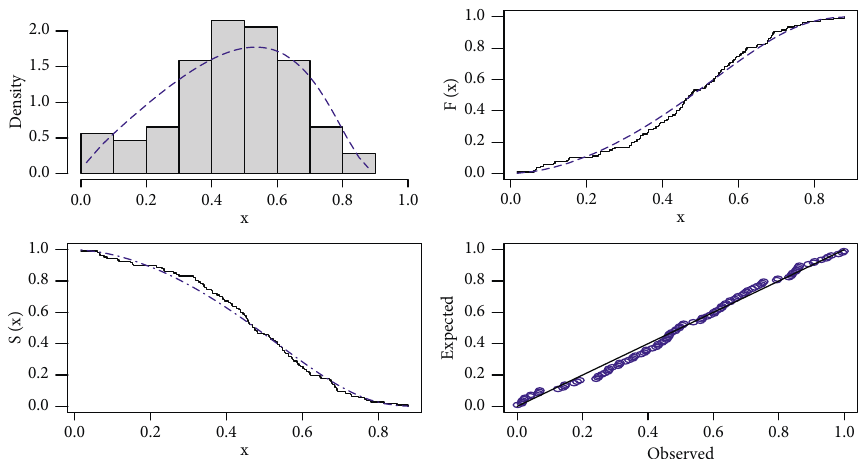
Figure 8: Histogram of the milk data set with the fitted PDF, CDF, SF, and P–P plots.